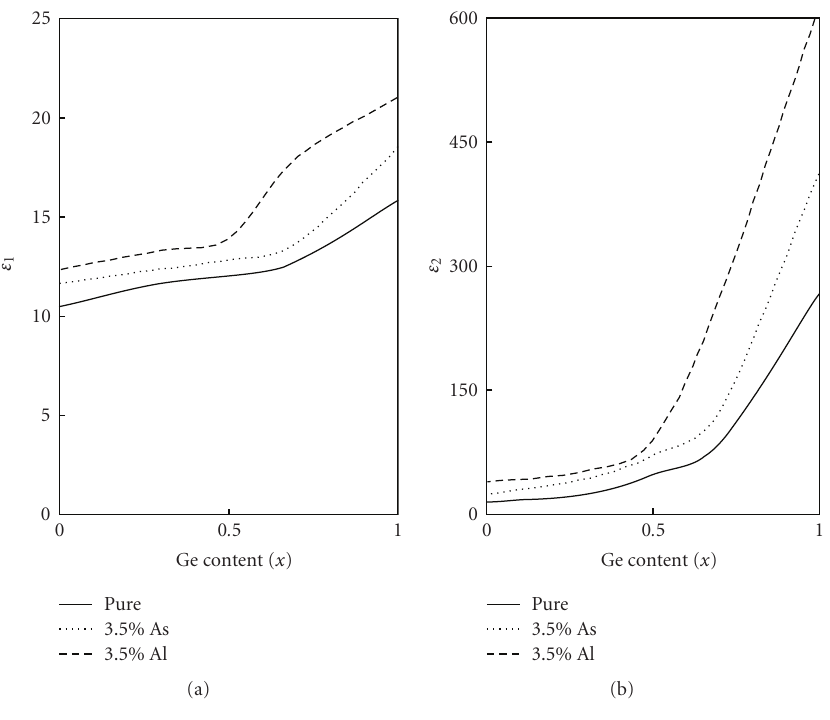
Figure 6: Variation of (a) ε 1 and (b) ε 2 with Ge content for pure and doped (3.5% As and 3.5% Al) for a-Ge x Si 1 − x :H